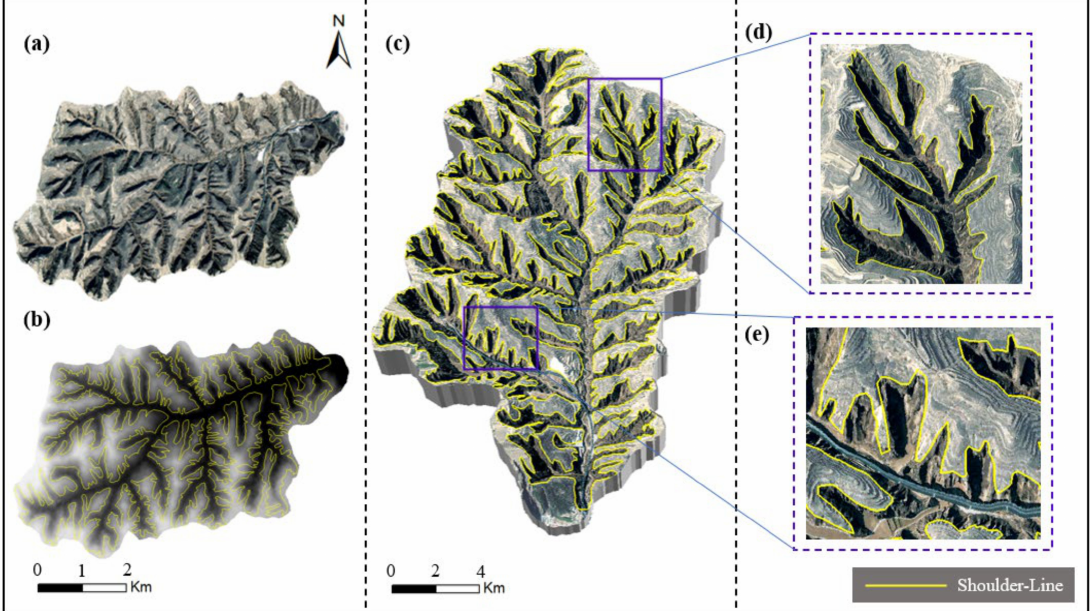
Figure 12. Result of automatic extraction: ( a ) remote sensing image map of the test area (acquired from Google Earth); ( b ) digital elevation model (DEM) of the test area; ( c ) 3D surface reconstruction of the test area; ( d ) jagged erosion; ( e ) palm-shaped